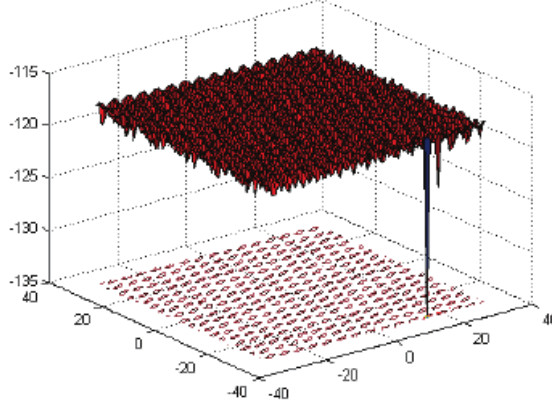
Fig. 4. The 2-dimensional fitness landscape of